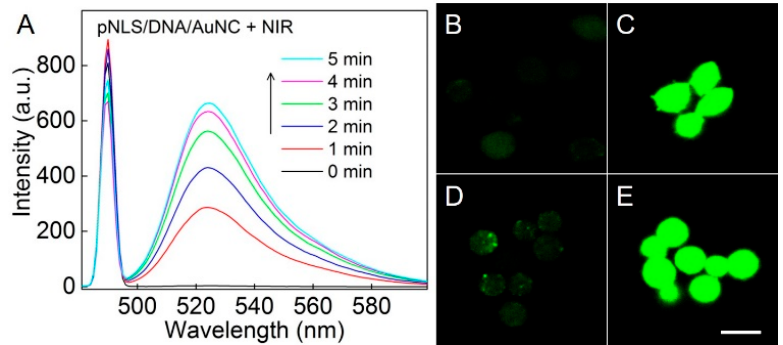
Figure 4. ( A ) ROS detection by DCFH in solution containing pNLS/DNA/AuNC complexes under NIR irradiation for different period. ROS detection by DCFH ‐ DA in cells treated with ( B ) AuNC; ( C ) AuNC + NIR irradiation; ( D ) pNLS/DNA/AuNC complexes; and ( E ) pNLS/DNA/AuNC complexes + NIR irradiation. Scale bar: 20 μ m. (Green channel: excitation at 488 nm, emission at 500–550 nm).